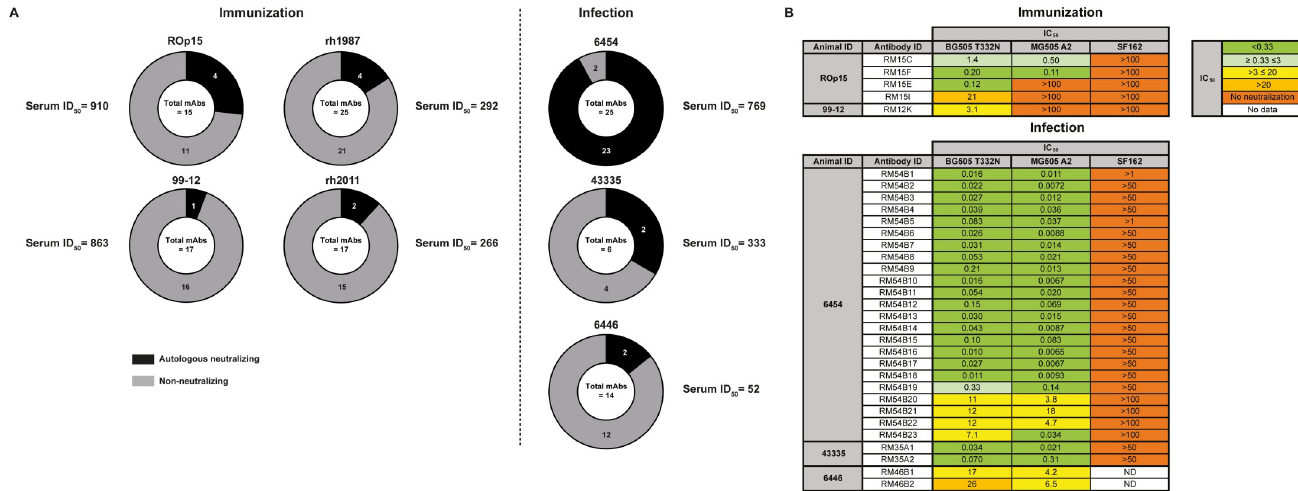
Fig 2. Autologous NAbs isolated from both the BG505 SOSIP-immunized and BG505 SHIV-infected NHPs. (A) Pie-charts indicating the amount of isolated mAbs able to neutralize the autologous BG505 T332N virus per NHP. We also included the information from mAbs that were previously isolated from two BG505 SOSIP.664-immunized NHPs (rh1987 and rh2011). The inhibitory dilution (ID 50 ) value next to the pie-chart indicates the autologous NAb titer of the serum at week 20 and week 24 post immunization and infection, respectively. (B) The half maximal inhibitory concentration (IC 50 ) values by which the NAbs neutralize the autologous BG505 T332N, closely-related MG505 A2, and heterologous SF162 viruses.